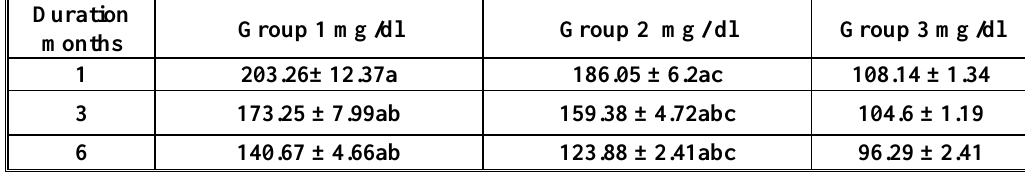
Table 2 : Effect of treatment with metformin 500 mg 3 times daily + glibenclamide 5 mg twice daily ( group 1) versus metformin 500 mg 3 times daily + sitagliptin 100 mg once daily (group 2) on postprandial plasma glucose PPG in patients with T2DM and control normal healthy individuals (group 3) after 1,3 and 6 months of treatment .( n = 34 individuals for each group ).